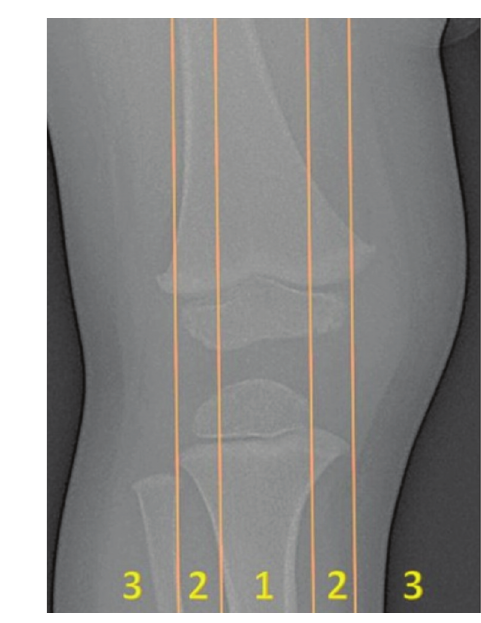
Anteroposterior view scanogram of a 3-year old boy with Fig. 2: left tibia vara. The BMI was 25. He was treated with an 8- plate over the proximal tibia (Case 4). (a) The initial mechanical axis (red line) of the left lower limb was in zone 3 (MAD zone 3). (b) Correction was achieved after 14 months (MAD zone